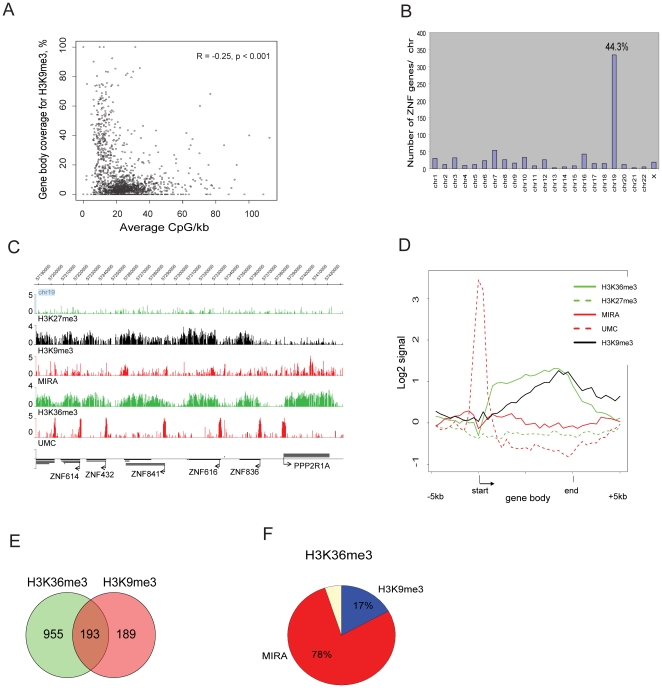
Epigenetic profile of ZNF genes on chr19 in human bronchial epithelial cells.
A. Genes located on chr19 sorted by CpG density in gene bodies and by percentage of gene body length covered by H3K9me3. B. Distribution of ZNF genes in the human genome. The number of ZNF genes on individual chromosomes is shown. C. Representative epigenetic profile of ZNF genes. Gene names, directions of transcription and gene coordinates on the chromosome are indicated. Note the simultaneous occupation of ZNF gene bodies by H3K9me3 and H3K36me3. D. Composite profile of genes with gene bodies marked by H3K36me3 and H3K9me3 over at least 20% of gene body length. Each gene body was divided into 20 and the 5 kb upstream of the TSS and 5 kb downstream of the 3' gene end were divided into 10 bins. The average signal for each single bin is indicated. E. Gene bodies marked by H3K9me3 and H3K36me3 on human chr19 in HBEC. The number of genes with gene bodies marked by H3K36me3 or H3K9me3 or by both marks over at least 20% of gene body length is shown (p = 0.02; Chi square test). Ninety percent of the dual-occupied genes are zinc finger genes. F. Genes marked by H3K36me3 on chr19 in HBEC. The diagram represents the distribution of H3K9me3 and DNA methylation in gene bodies containing H3K36me3. Genes were assumed to carry a specific modification if at least 20% of gene body length was covered by the analyzed mark. Co-occupancy of H3K9me3 and H3K36me3 is a hallmark of ZNF genes.